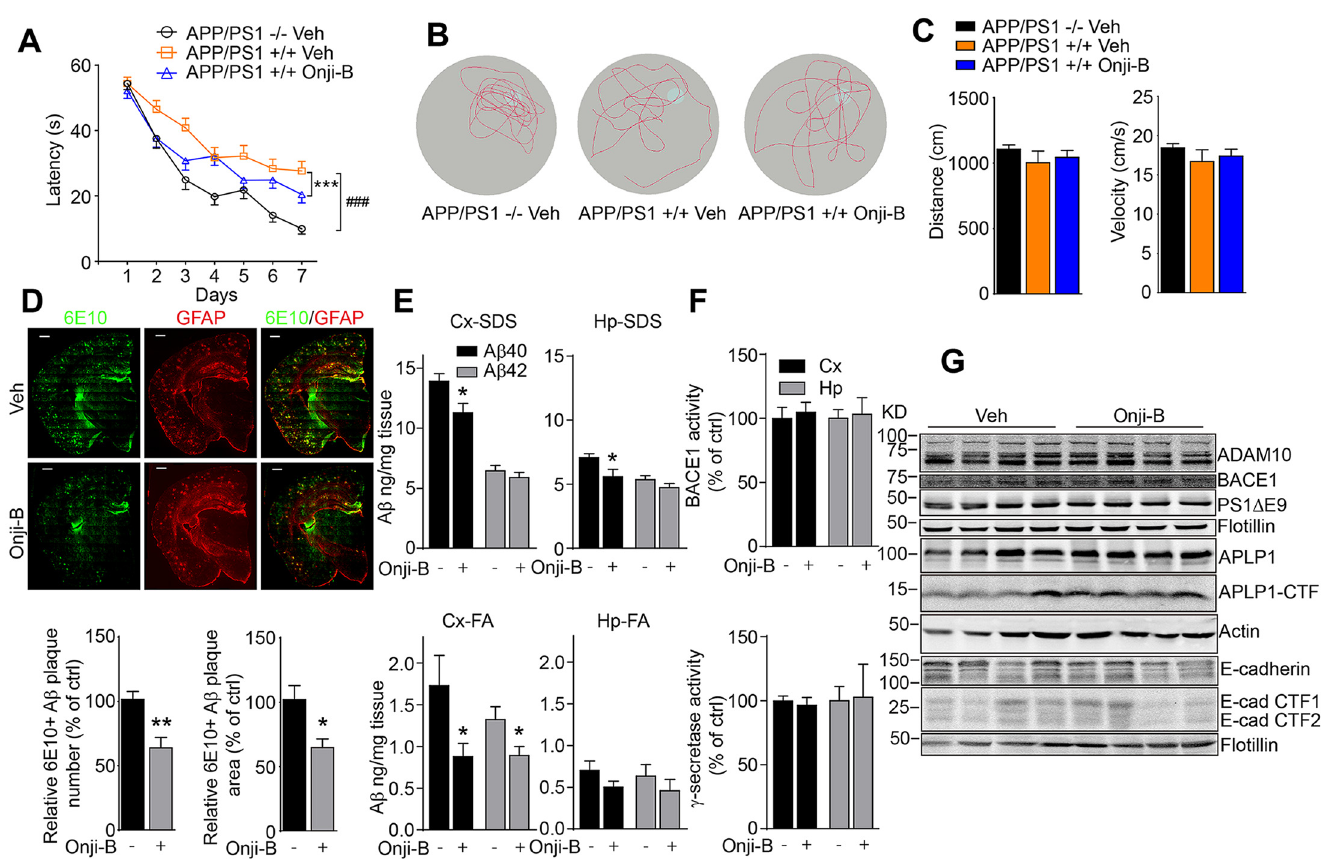
Fig 4. Onjisaponin B ameliorates cognitive impairments in APP/PS1 mice. (A) Onjisaponin B significantly attenuates spatial memory deficits of AD mice in the Morris Water Maze test. (B) Representative tracks of each group of mice in the probe trial test at day 8. (C) The swimming distance and velocity of mice. (D) Representative images of A β plaques in APP/PS1 mice immunostained with the A β antibody 6E10 in coronal mouse brain cryo-sections (n = 6 per group). The number and area of A β plaques, which are immunoreactive to 6E10, were quantified from entire brain sections using Image-Pro Plus 5.1 software (Media Cybernetics). Ten to fifteen coronal sections per mouse were analyzed. (E) SDS-soluble and FA-soluble A β 40 and A β 42 levels in mouse hippocampus and cortex measured by ELISA. (F) Mouse hippocampal and cortical BACE1 and γ -secretase activities and (G) Western blot analysis of cortical protein extracts with indicated antibodies. Data are presented as the mean ± s.e.m. * p < 0.05, ** p < 0.01 and *** p < 0.001. Two-way ANOVA with Bonferroni's multiple comparison test (A), one-way ANOVA with Bonferroni's multiple comparison test (C) and two-tailed t -test (D, E and F).